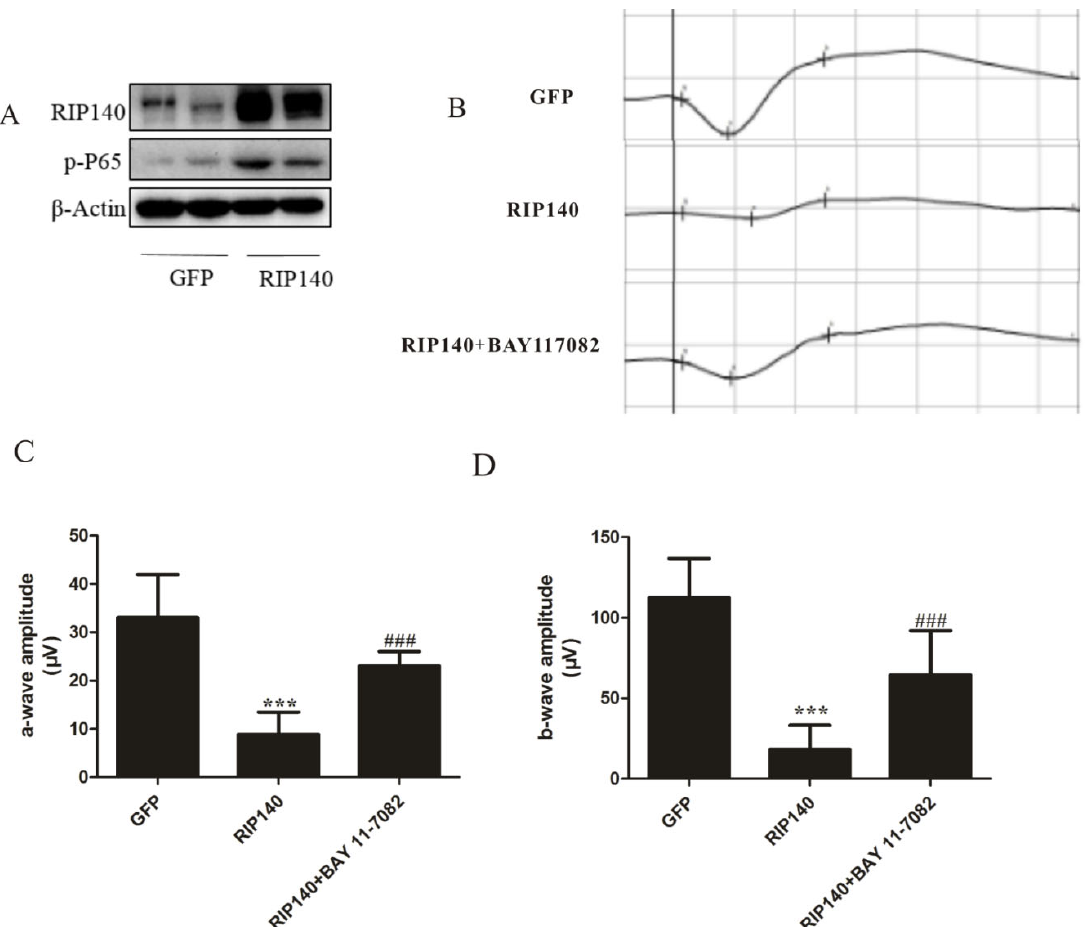
Figure 5. RIP140 ‐ mediated NF ‐κ B inflammatory pathway involved in photoreceptor functional impairments. ( A ) Western blot showing the expression of RIP140 in the retina 10 days after delivery with adenovirus. ( B ) ERGs from a different group. Amplitude ( μ V) of ( C ) the a ‐ wave and ( D ) the b ‐ wave. *** p < 0.001, compared with Ad ‐ GFP group. ### p < 0.001 vs. Ad ‐ RIP140 group.